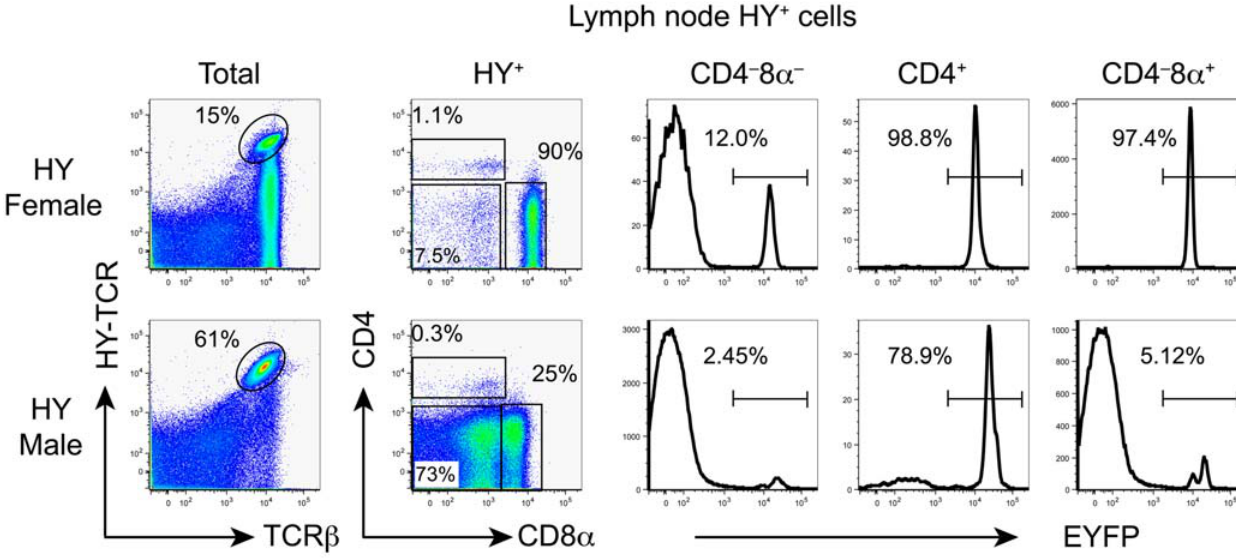
Figure 3. Fate mapping of lymph node T cells with the transgenic HY-TCR using ROR c t-cre. CD4 and CD8 a expression by gated HY (T3.70) + lymph node cells (left column) is shown in the second column. EYFP expression by HY + CD4 2 CD8 a 2 , HY + CD4 + CD8 a 2 and HY + CD4 2 CD8 a + T cells is shown.